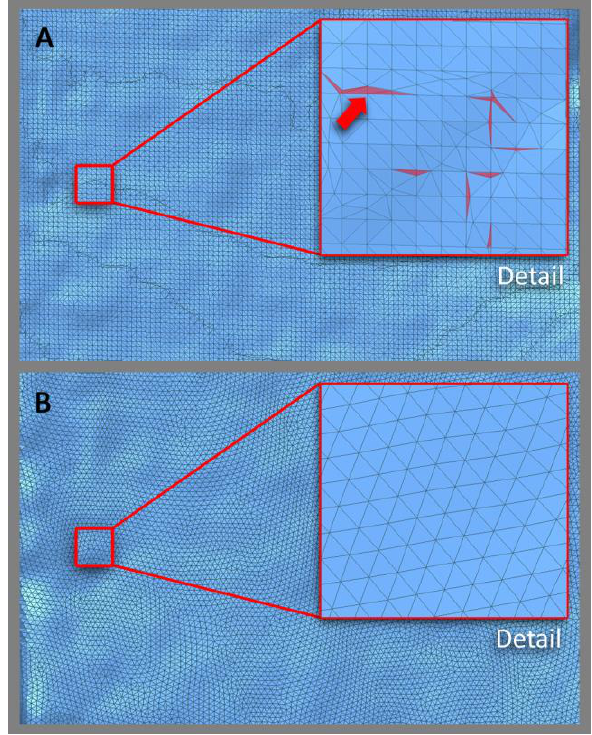
Figure 4. A) the initial mesh from SfM application with geometrical and topological errors. B) the isotropic mesh obtained through global